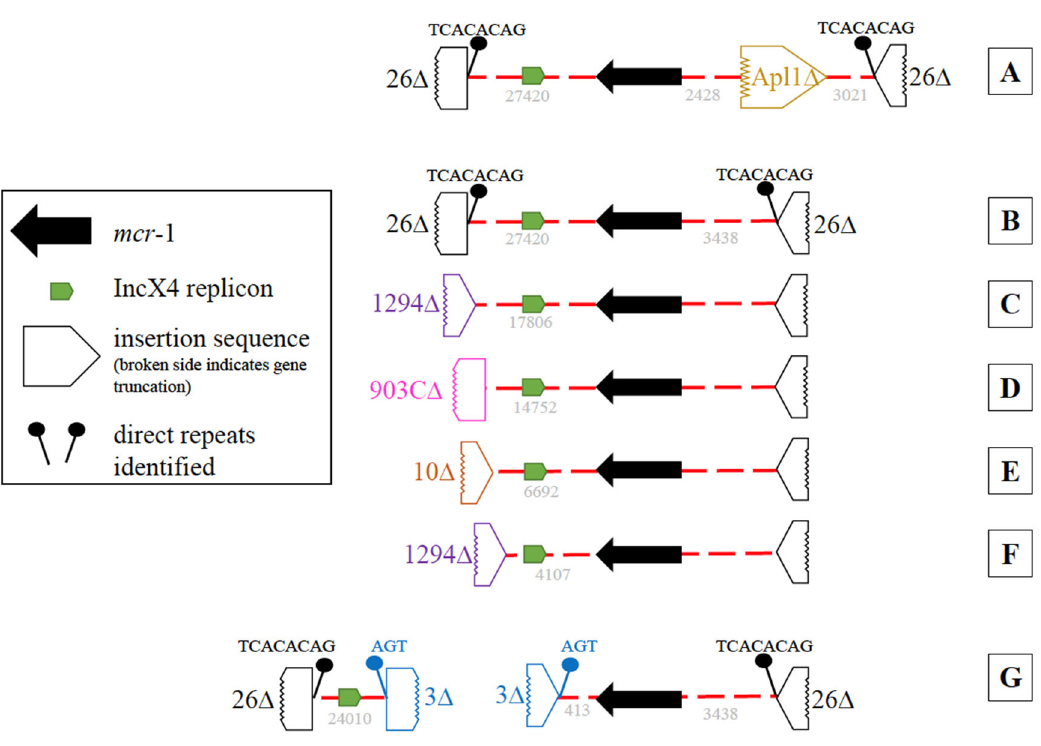
Figure 4. Diagrams of the genetic variation of the mcr -1 and IncX4 harboring contigs. An IncX4 plasmid replicon, mcr -1, and two partial IS26 with direct repeats (TCACACAG) were identified in variation ( A – G ). The IncX4 and mcr -1 were on the same contig in variations ( A – F ), which differed in length due to the presence of partial insertion sequences either at one end of the contig resulting in shorter contigs (( B – F ); IS 1294 , IS 903C, or IS 10 ) or by the presence of a single IS Apl1 ~2.4 kb upstream of the mcr -1 ( A ). In variation G, mcr -1 and IncX4 were on different contigs and portions of IS 3 with direct repeats (AGT) were found on one end of each contig.